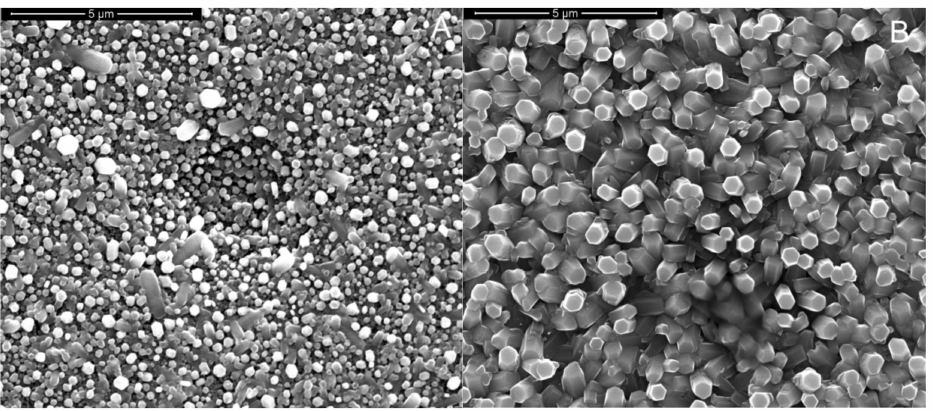
Figure 4. SEM images of the samples obtained in a de-aerated solution of 10 mM ZnCl 2 10 mM NaNO 3 at − 1V: ( A ) 80 ◦ C, 60 min, untreated pH 6.5–6.8, ( B ) 60 ◦ C, 60 min, pH